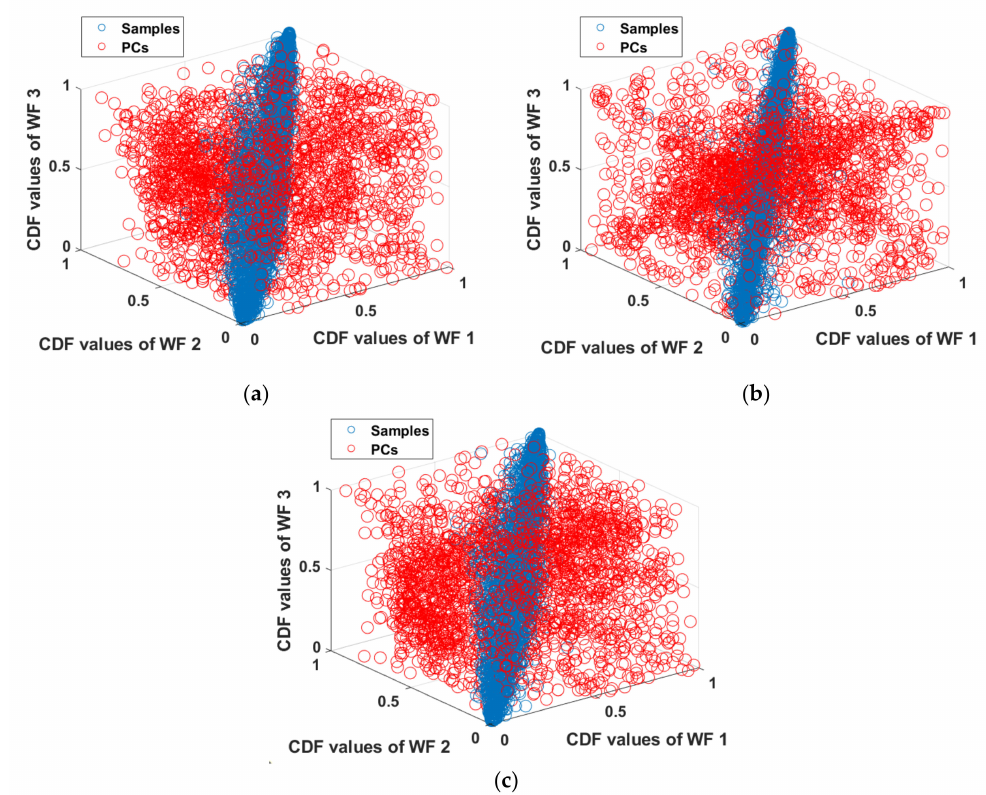
Figure 5. Sample scatter plots with related PCs ( a ) at the 7th hour, ( b ) at the 15th hour, ( c ) at the 23rd hour.